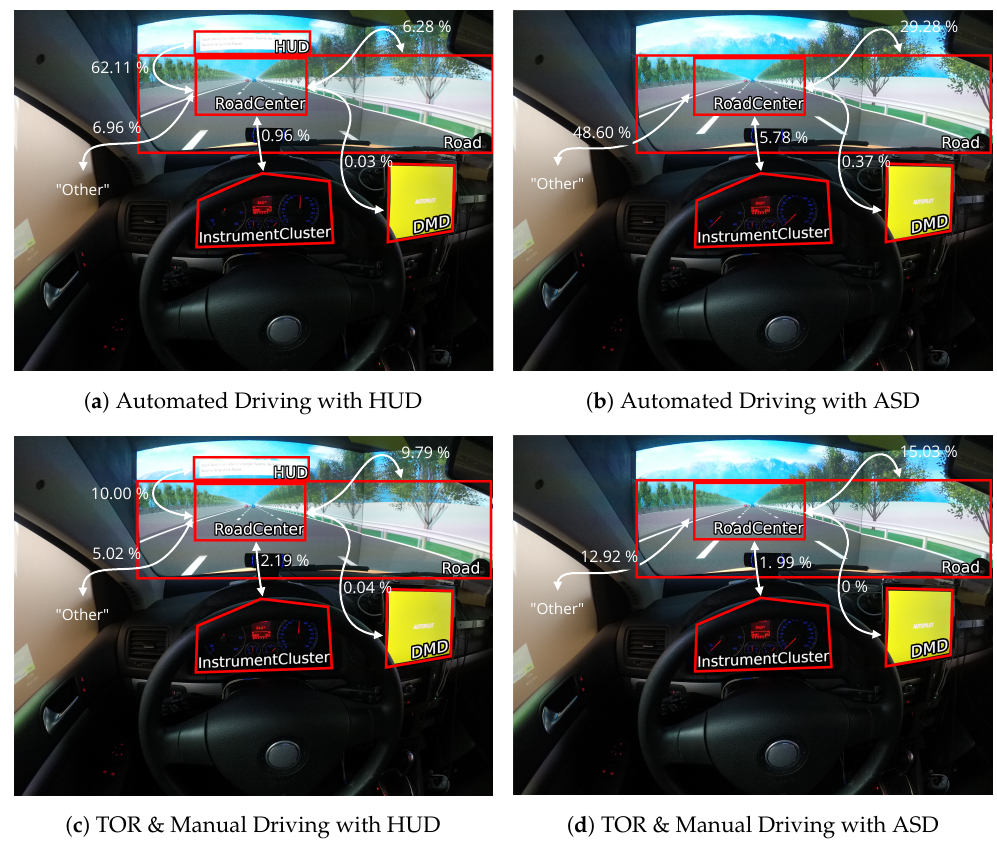
Figure 5. Mean link value probabilities between analyzed AoIs depicted as white double-headed arrows with probability labels: during automated driving ( a , b ) and during take-over phases with manual driving and handback to to automated driving ( c , d ) per condition (HUD, a , c ; ASD, b , d ). The HUD was not visible during